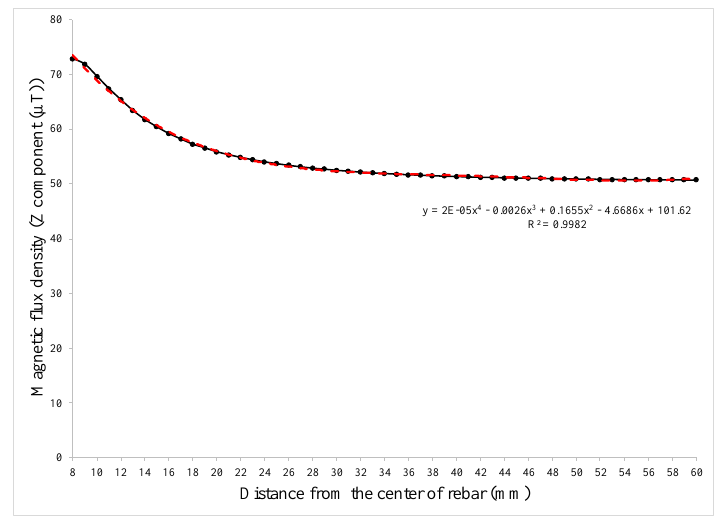
Figure 17. Behavior of the minimum values of the Z-component magnetic flux density, from 295.0592 mm to 307.0592 mm (values related to Hole 2), of rebar mesh #8 and box mesh #5, recorded at different vertical distances.